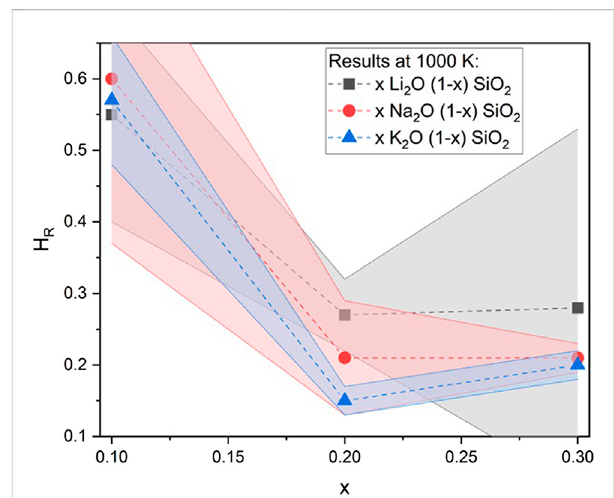
FIGURE 6 Haven ’ s ratio (H R ) for the different glasses used in this research at 1000 K. Values of H R are higher for low concentrations (x = 0.1) and decrease with increasing alkali concentration (x = 0.2 and 0.3). Similar behavior was found for other glass systems (Isard, 1999) and crystals (Murch, 1982) in laboratory